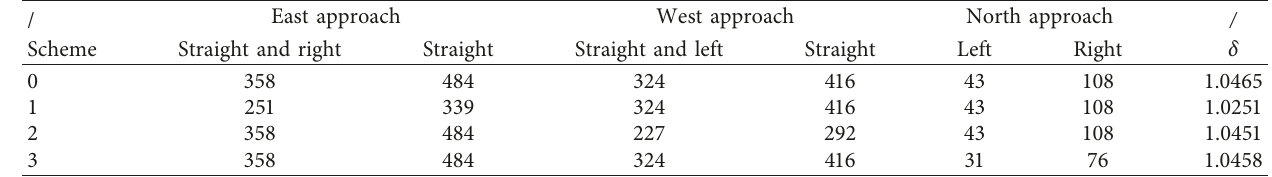
Figure 9: Conflict distribution of intersections before and after signal timing optimization. (a) Conflict distribution of intersection under original signal timing scheme. (b) Conflict distribution of intersection under the optimized signal timing scheme. Table 6: Parameters and safety assessment of flow control measures